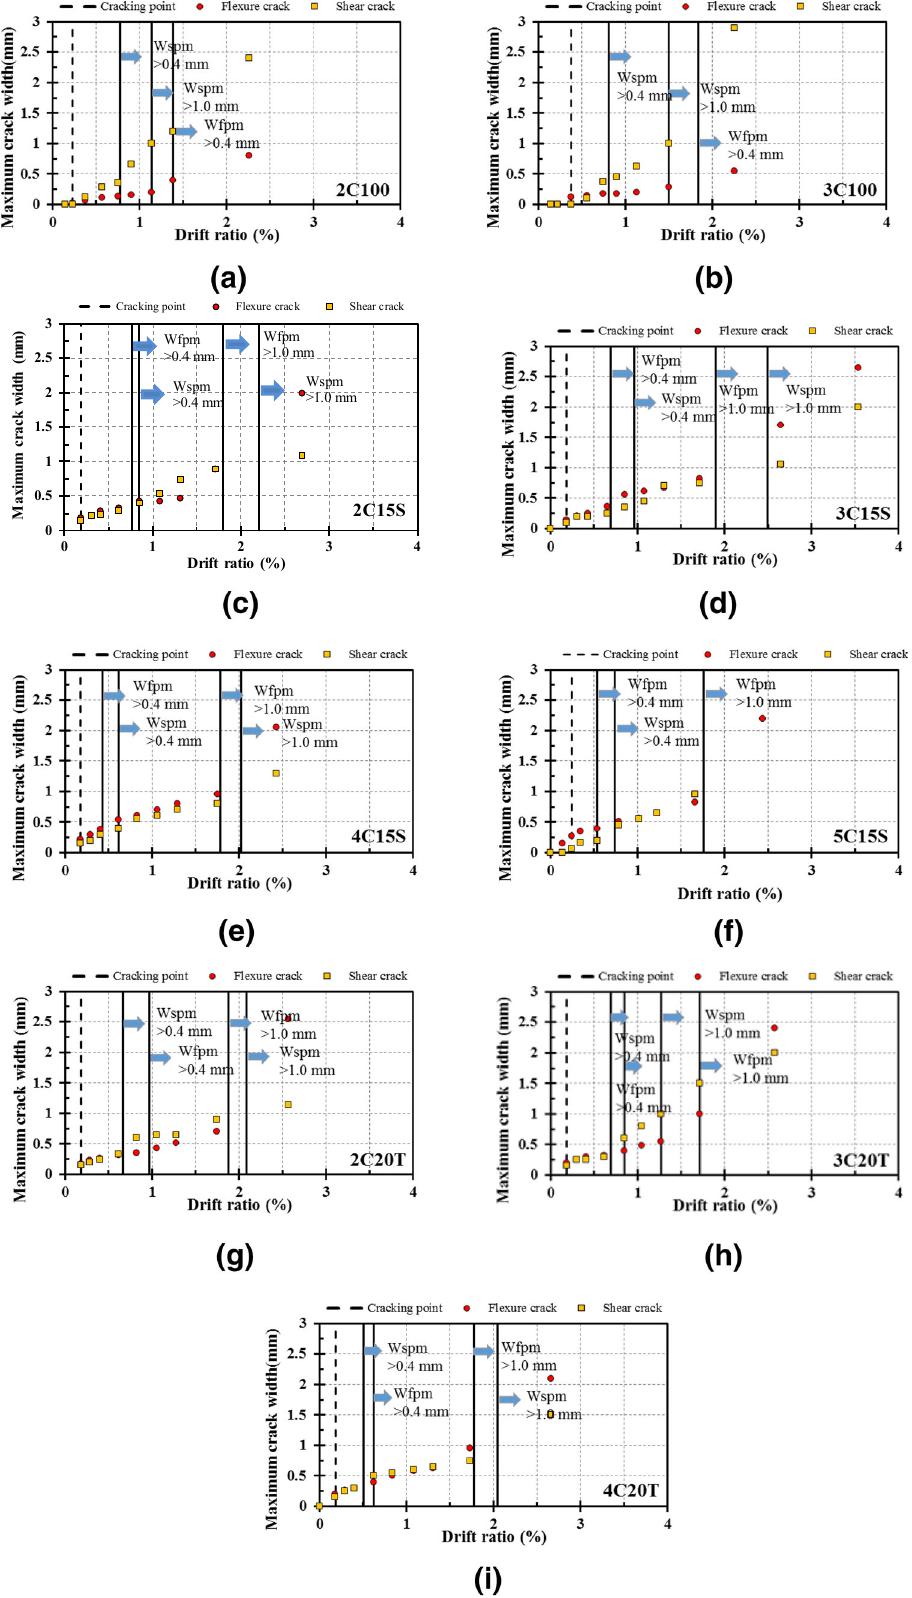
Fig. 12 Maximum crack width under various peak deformation angles. a 2C100, b 3C100, c 2C15S, d 3C15S, e 4C15S, f 5C15S, g 2C20T, h 3C20T, and i